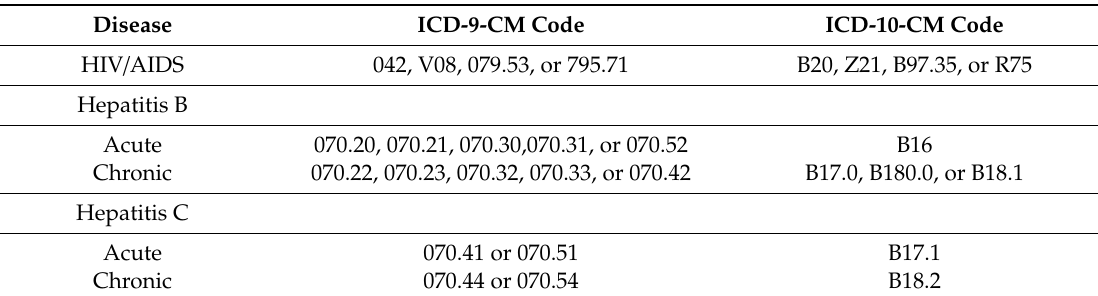
Table A1. International Classification of Diseases, 9th Revision, Clinical Modification (ICD-9-CM) and International Classification of Diseases, 10th Revision, Clinical Modification (ICD-10-CM) Codes for HIV, HBV and HCV Infection Used in the